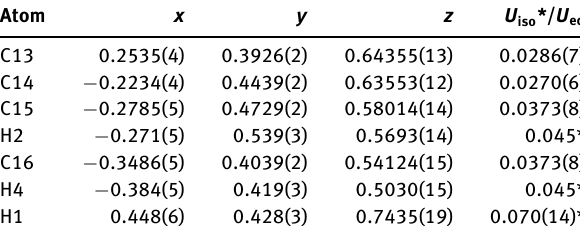
Table 2: Fractional atomic coordinates and isotropic or equivalent isotropic displacement parameters (Å 2